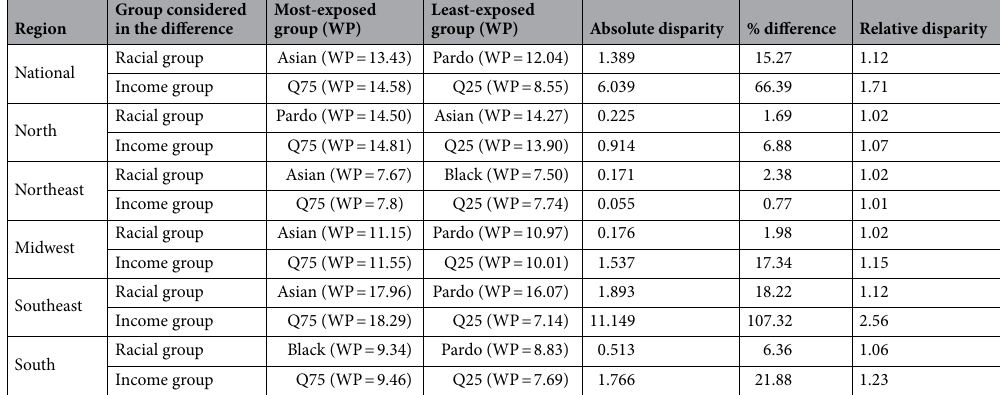
Table 3. Difference between the population-weighted PM 2.5 for the most-exposed group (racial and income group) versus the least-exposed group. Note 1 : population-weighted weather penalty (WP), third quartile of the income distribution (Q75), first quartile of the income distribution